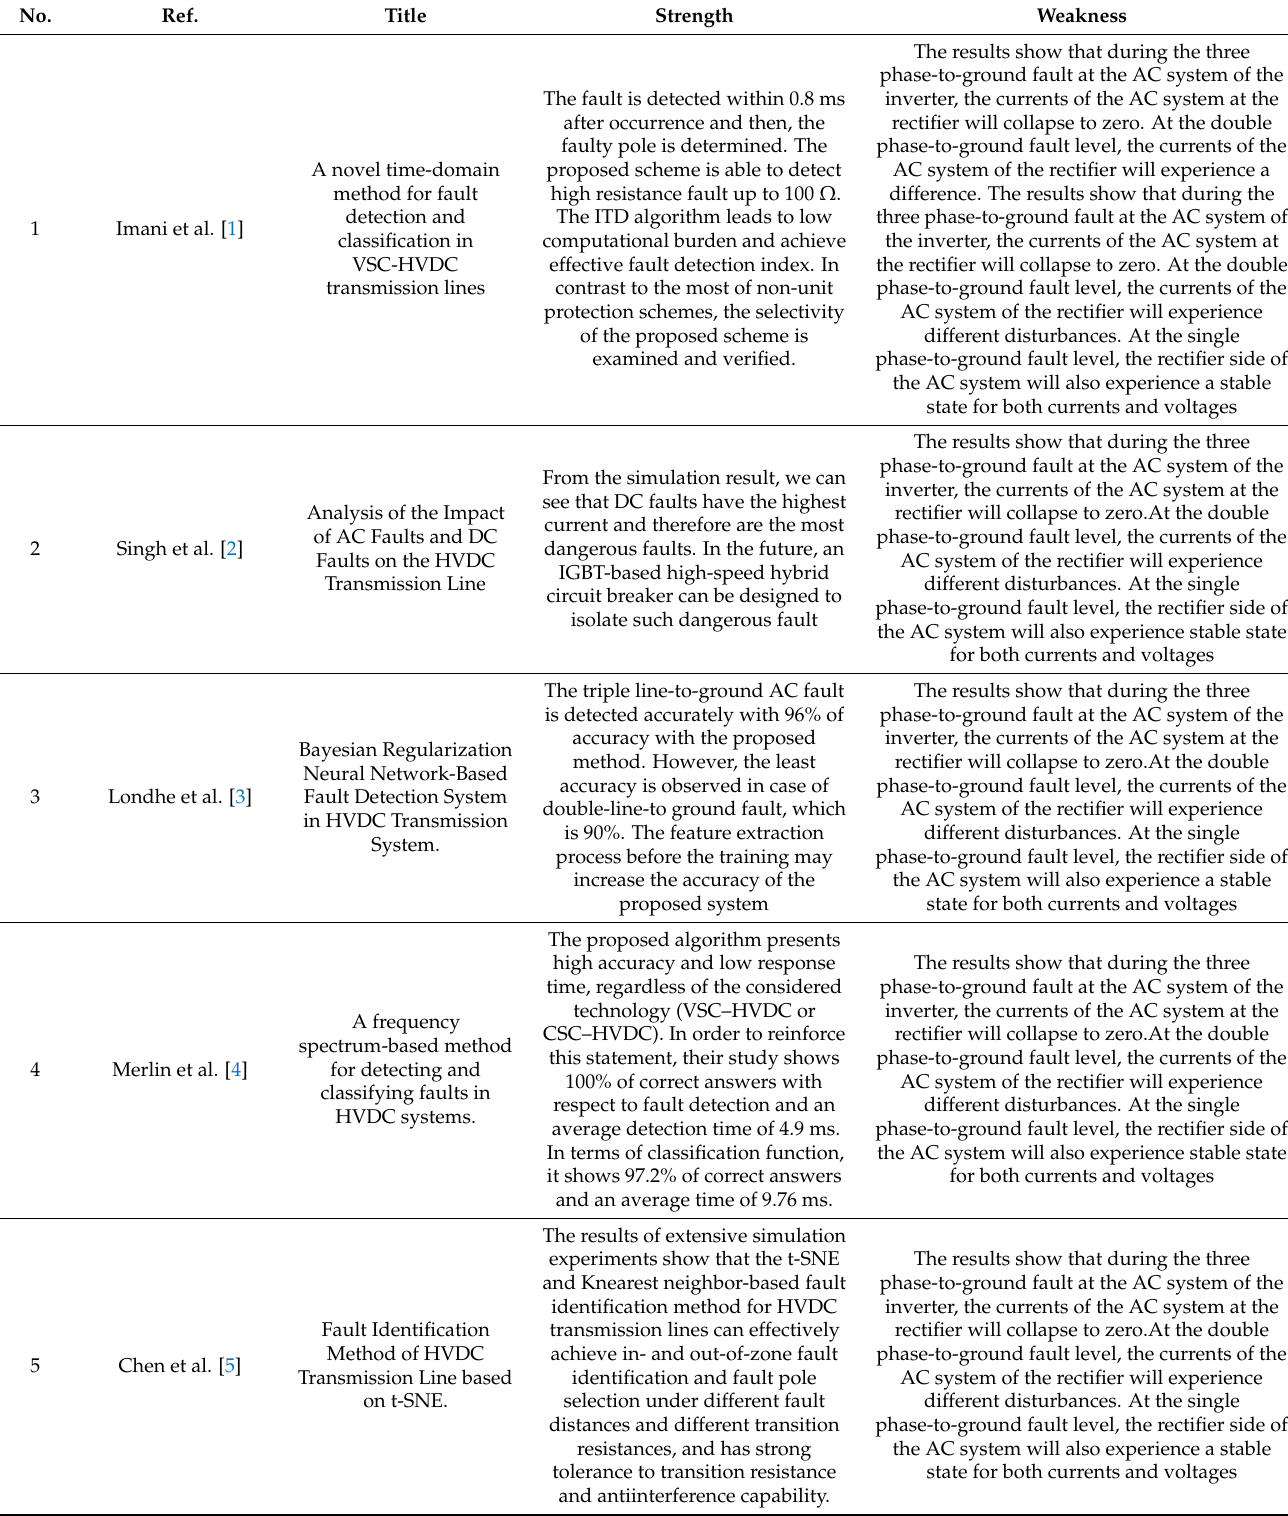
Table 1. Overview of the Literature